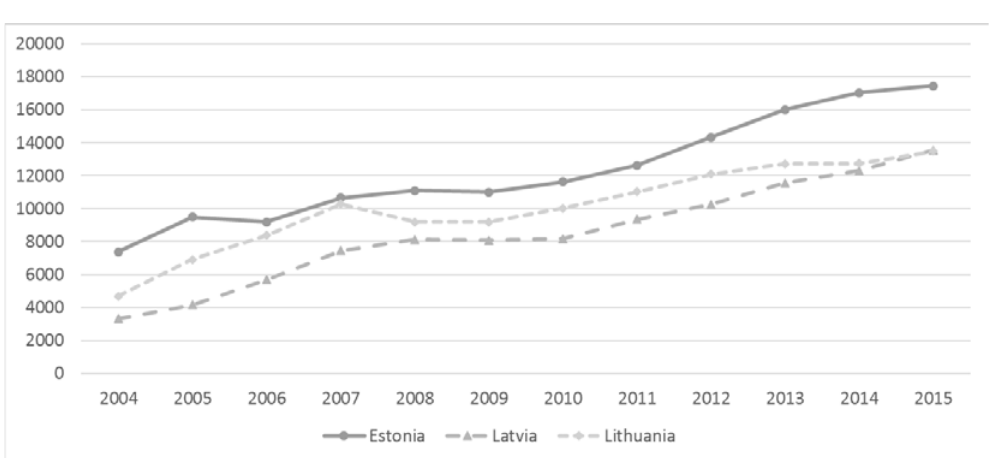
Fig. 1. Accumulated foreign direct investment in the Baltic States, million EUR (Ministry of Economics,